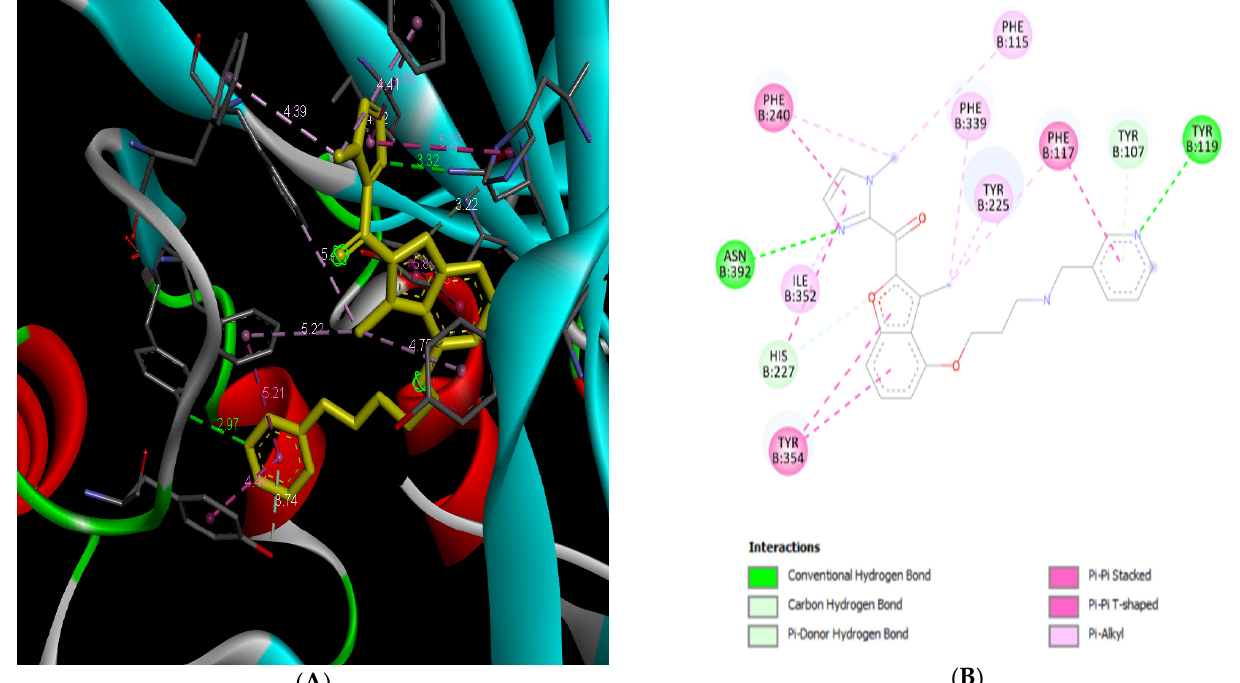
Figure 9. 2D ( B ) and 3D ( A ) representation of compound 7 docking with Nmt.